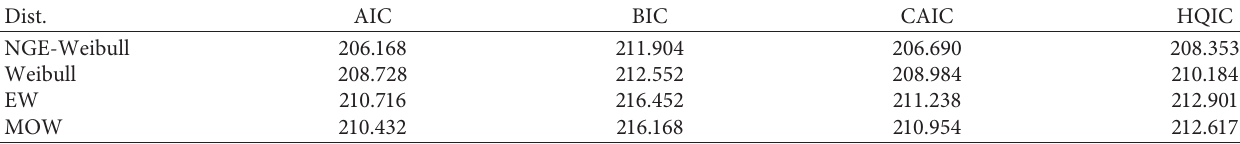
Table 4: The discrimination measures of the competing models for the failure time data.